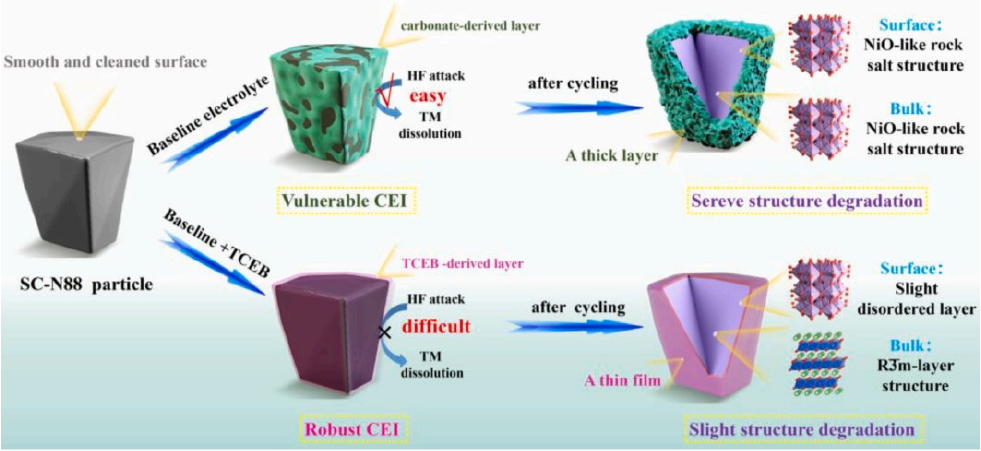
Figure 10. Schematic illustration of the protective effect of TCEB on single-crystal LiNi 0.88 Co 0.09 Mn 0.03 O 2 . Reproduced from Ref [299], Copyright 2022, Elsevier.